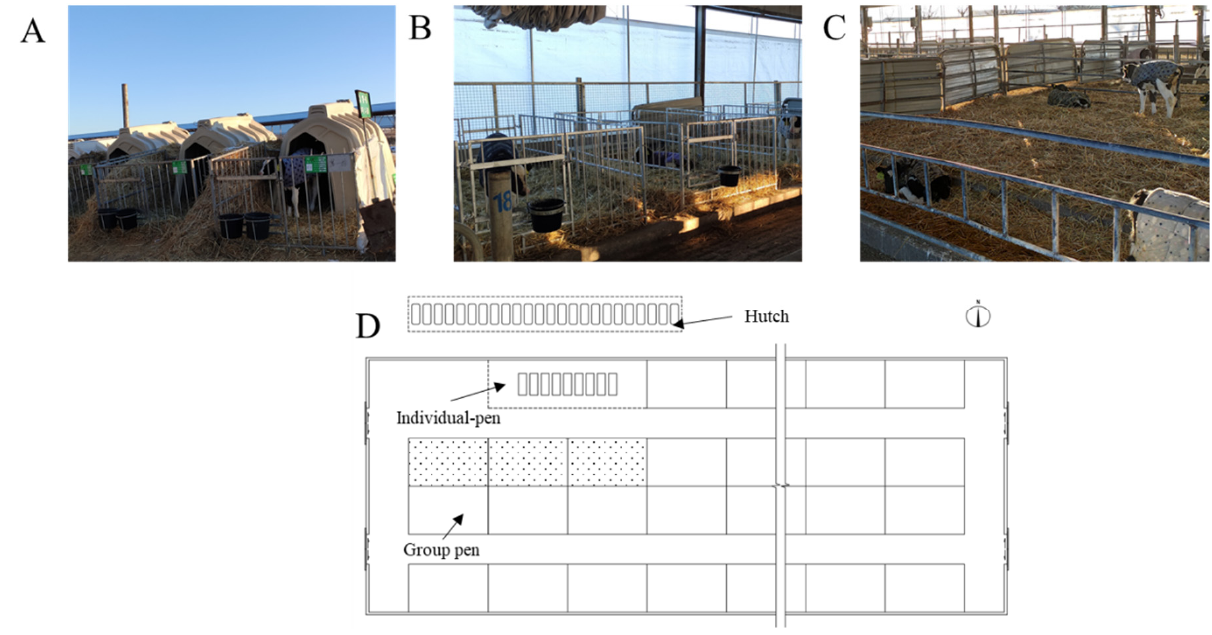
Figure 1. The photos showing ( A ) outdoor hutches, ( B ) individual pens, and ( C ) group pens inside the barn, and the schematic for the ( D ) calf